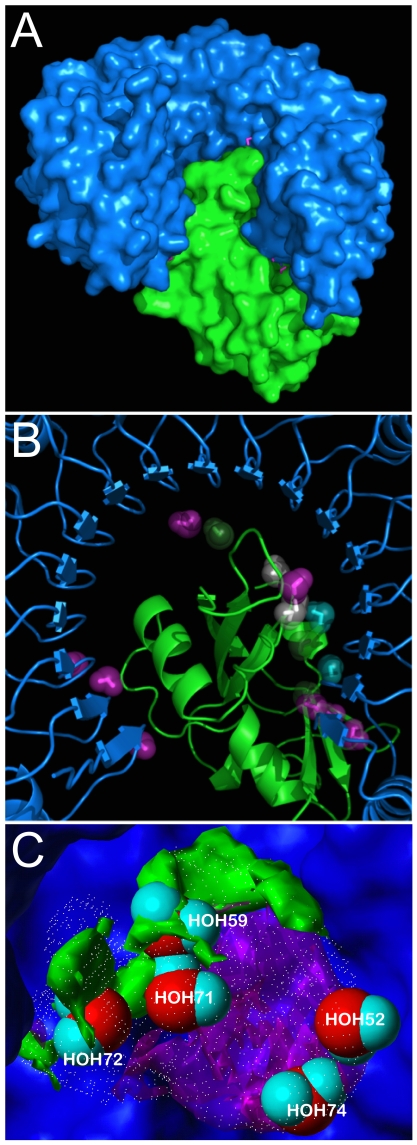
Molecular model of human placental RNase inhibitor (hRI)- human angiogenin (hAng) complex (1a4y).(A) Connolly-type surface representation with blue for hRI and green for hAng; (B) Interface region; water molecules colored blue are Relevant (≥ 0.25) with respect to hRI, green with respect to hAng, magenta with respect to both hRI and hAng, and white with respect to neither (see Table 2); (C) Of particular interest is the “hydrophobic bubble” enclosing the non-Relevant waters HOH59, HOH71 and HOH72. Note that these three waters are encompassed within a region of the cavity (rendered with white dots by VICE [84]) that is of hydrophobic character (green contours) as indicated by focused HINT complement maps [85]. HOH52 and HOH74 are also in the cavity but in a polar region (magenta contours). The pocket map is set on the surface of hRI; the structure and surface for hAng has been deleted for clarity.